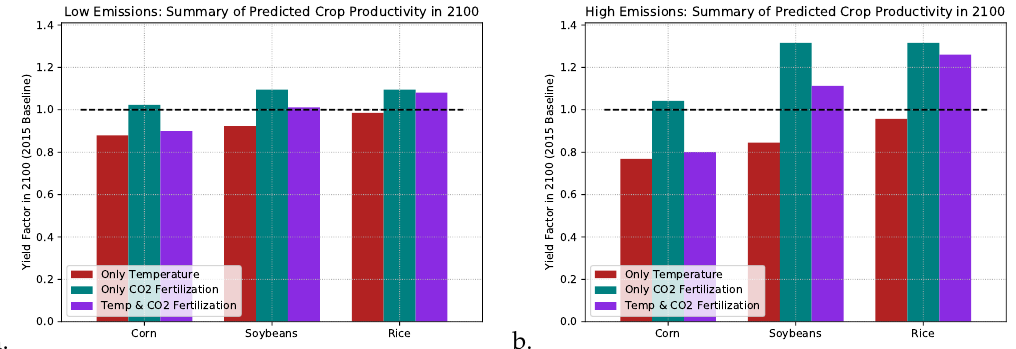
Figure 8. Crop productivity averaged over 2096–2100, compared to a 2011 through 2015 baseline for a low ( a ) and high ( b ) emissions scenario. Estimates are based on only temperatures (red), only CO 2 fertilization (teal), and both assuming compounding effects